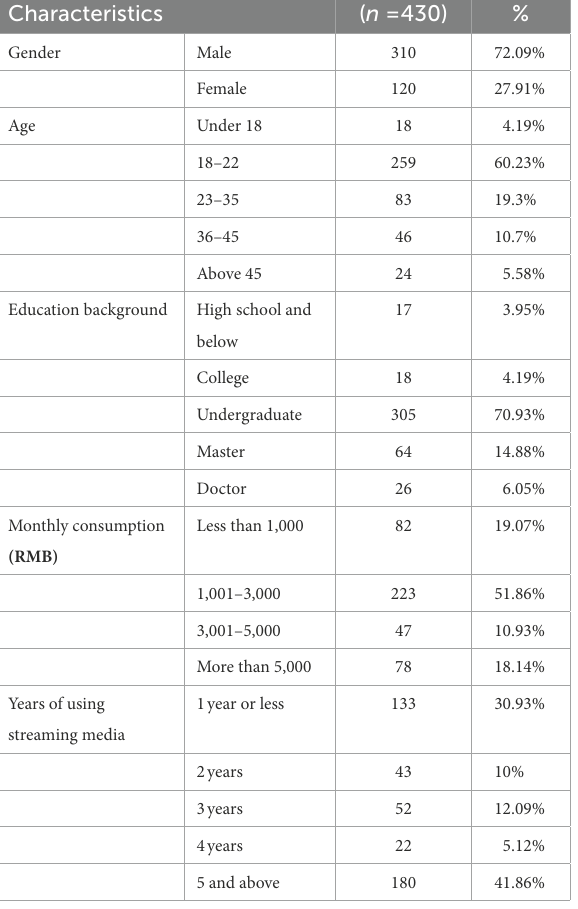
TABLE 1 Demographic characteristics of the